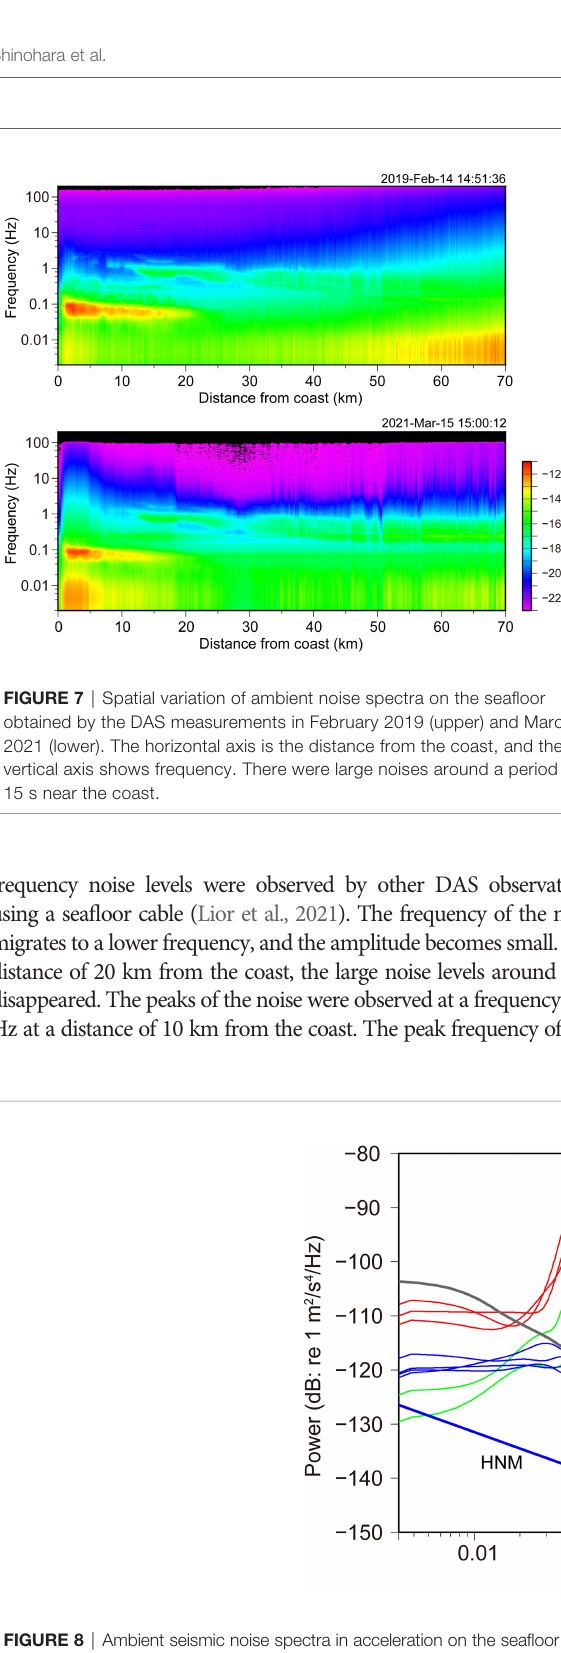
FIGURE 8 | Ambient seismic noise spectra in acceleration on the sea fl oor estimated using the DAS observation data. The DAS data were converted to particle acceleration under an assumption of plane wave propagation. For the conversion, a wave propagation velocity of 500 m/s was used. The data length for the estimation of the spectra was approximately 524 s. Colors of lines indicate a distance range from the coast. The gray lines denote a typical ambient seismic noise spectrum of the X-component at the SOB3, which is positioned at a distance of approximately 50 km from the coast. The HNM and LNM are also displayed (Peterson, 1993). Noise levels of the DAS measurement are comparable to that of a conventional accelerometer in frequencies greater than 0.5